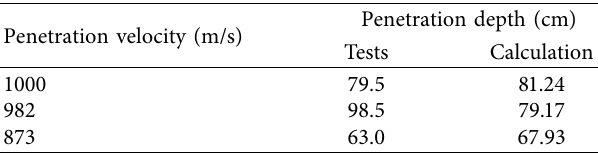
Table 3: Comparison between tests and modified formula of penetration